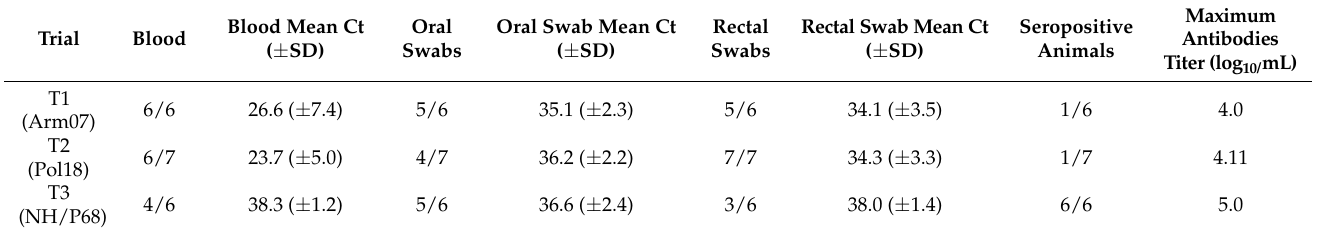
Table 2. The detection of ASF DNA in relevant matrices or specific anti-ASFV antibodies in the respective trial